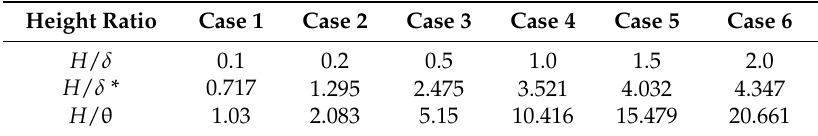
Table 2. Ratio of VG Height to Different BL Thickness.